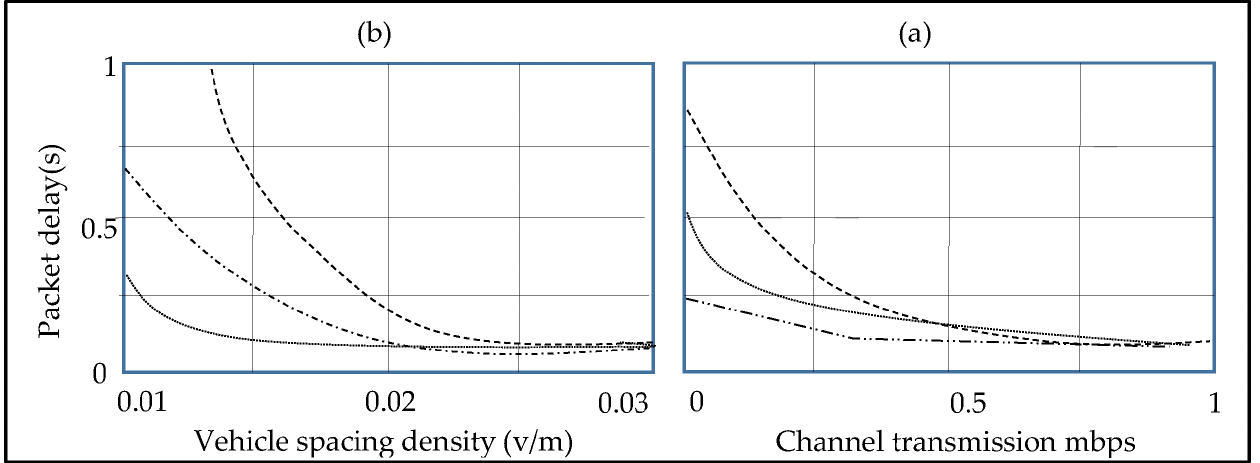
Figure 5. Road segment packet delay in the transmission channel. ( a , b ) depict the relationship between the road section delay, cell size, CTR, and the spacing density of the UGV.